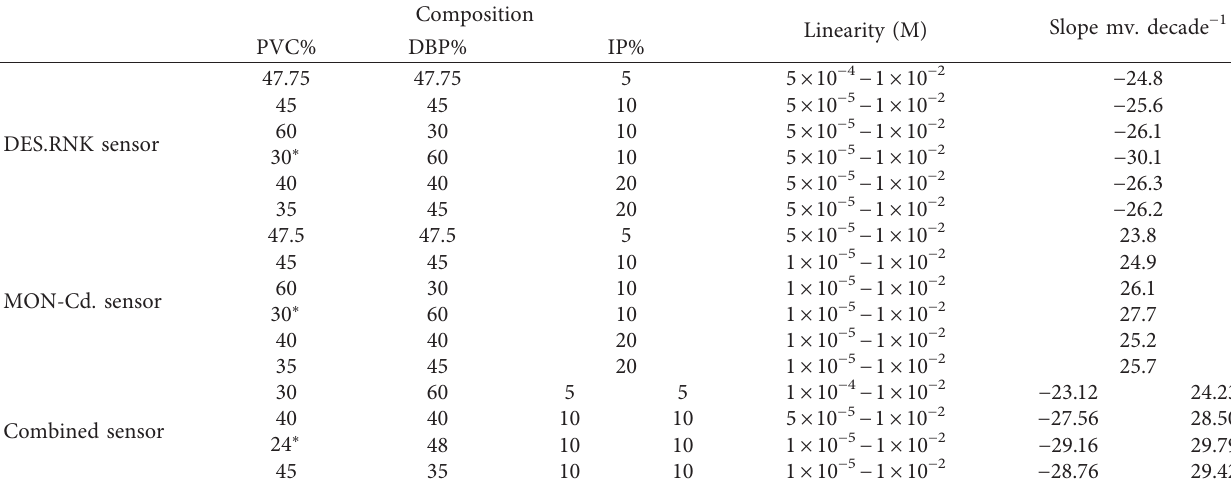
3.6. Method Validation. We have validated the proposed method, according to the ICH rules [36] as following. 3.6.1. Linearity. To estimate the linearity range of the constructed sensors, the potentials of a standard series consisting of 10 concentrations ranging between 1 × 10 − 6 M and 1 × 10 − 1 M were measured to get the regression equation for each sensor; the linearity range was found to be sensor and MON sensor respectively, as shown in Figures 9 and 10. When we used the combined sensor, we noticed a wider linearity range for both drugs 1 × 10 − 5 − 1 × 10 − 2 M and 5 × 10 − 6 − 1 × 10 − 2 M for DES and MON, respectively, that maybe due to the higher percentage of the electroactive material in membrane composition.